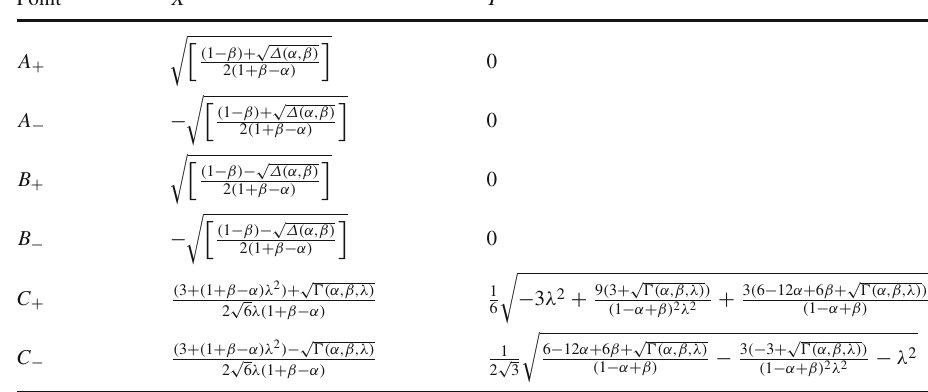
Table 2 Critical points of the dynamical system for α = 0 Point